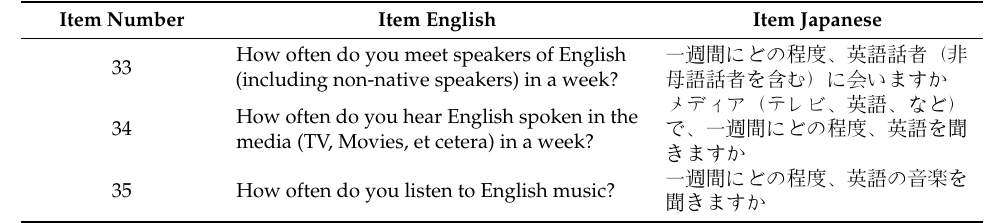
Table A8. English